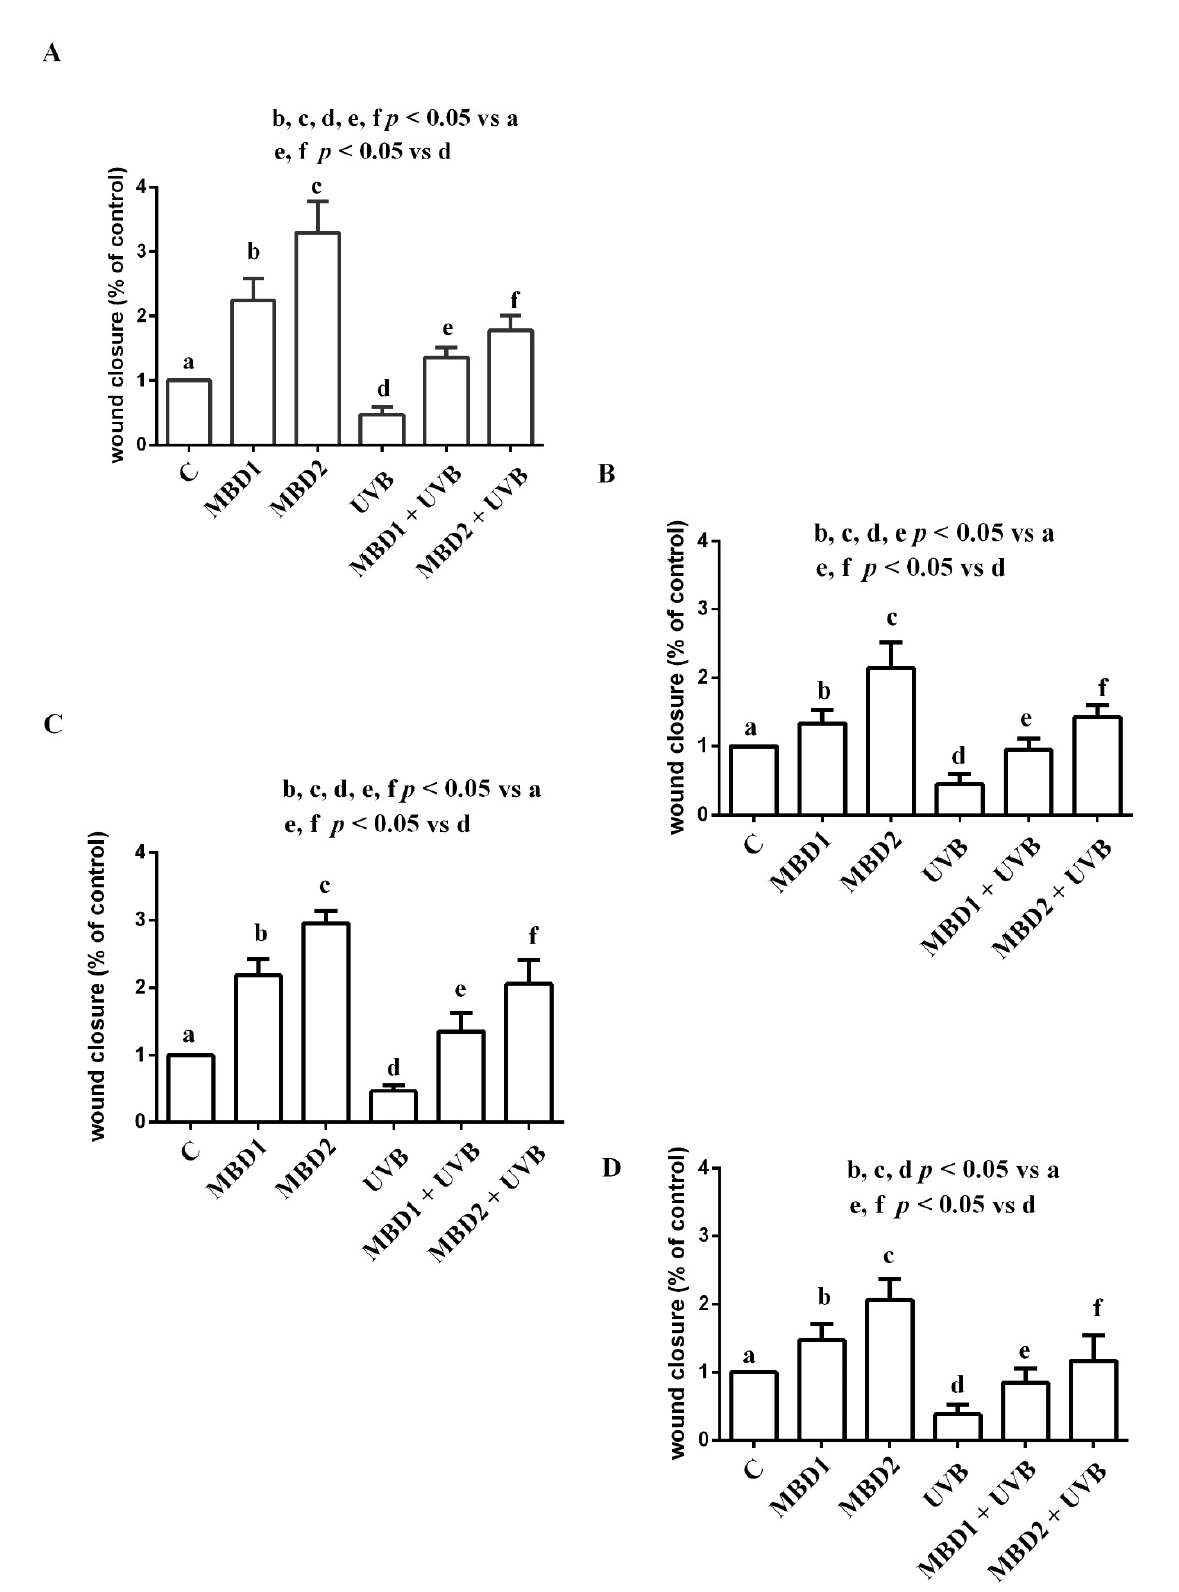
Figure 7. Effects of MBD with ( A , C ) and without PEG ( B , D ) on migration in ARPE-19 cells ( A , B ) and RGC-5 cells ( C , D ). MBD1: MBD at 3 × 10 −5 M. MBD2: MBD at 7.8 × 10 −4 M. UVB at 0.117 J/cm 2 (for 30 min). The results are means ± SD of repeated experiments. C: control cells (non-treated).